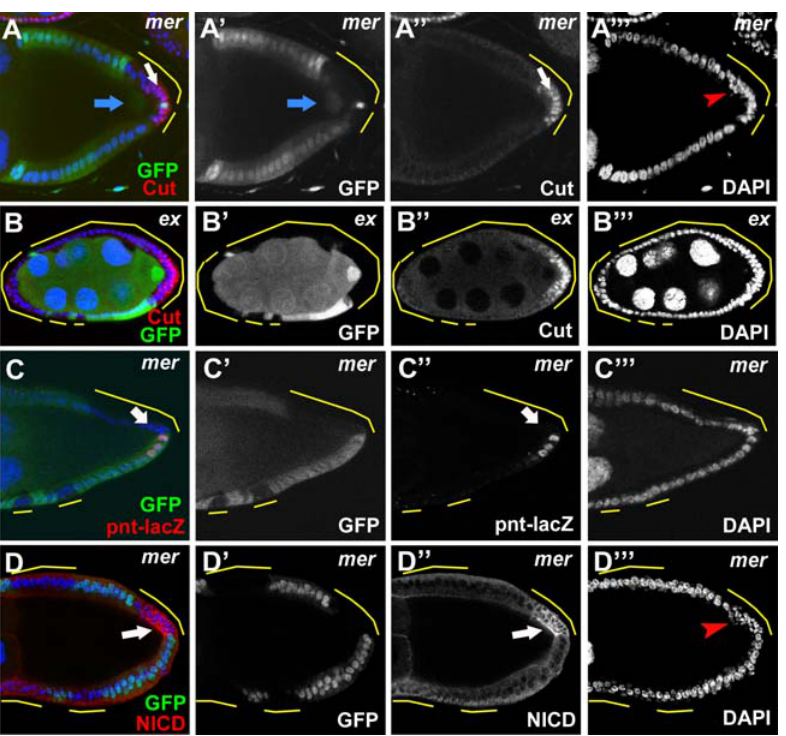
Figure 8. mer mutation disrupts PFC fate and Notch signaling. (A) mer clones lead oocyte nucleus mislocalization (blue arrow), and misexpression of Cut (white arrow) in the PFC clones of this stage 10 egg chamber. (B) Similar defects can also be observed in ex clones of this stage 7 egg chamber, although the penetrance was significantly lower (see Results). (C) Loss of pnt-lacZ expression was observed in mer PFC clones (arrow). (D) mer PFC clones accumulate high levels of NICD. Multilayering and small nuclei could also be seen in mer PFC clones (A’’’,D’’’, red